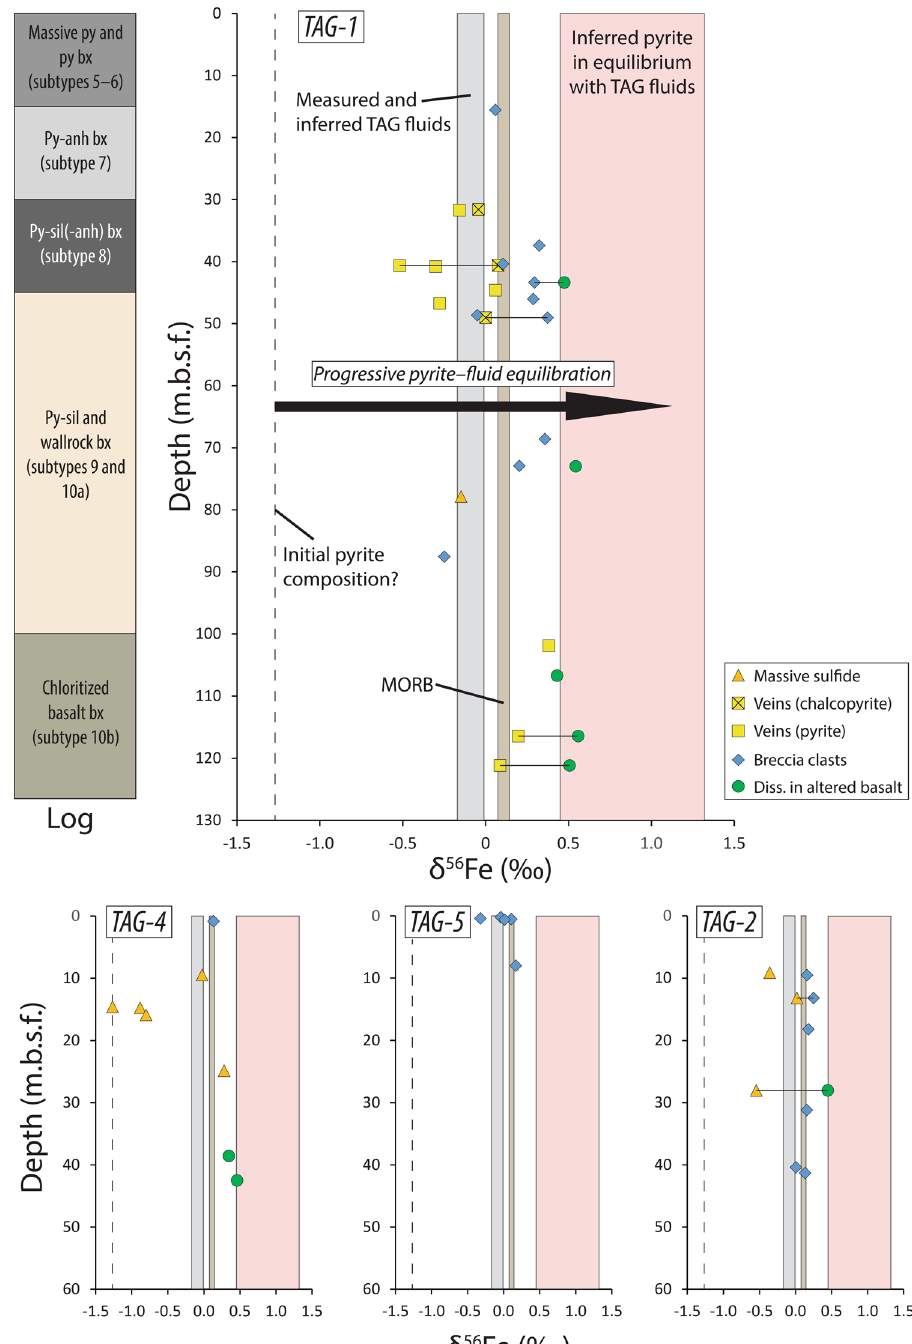
Fig. 3 Iron isotope results. The δ 56 Fe values of pyrite ( n = 47) and chalcopyrite ( n = 3) from TAG-1, TAG-2, TAG-4, and TAG-5, respectively, are plotted as a function of depth below the mound surface. Tie-lines connect sul fi de samples obtained from the same drill core piece. Included are the core log for TAG-1 44 and reference fi elds for MORB (brown) 23,56 and for measured 28 and inferred TAG hydrothermal fl uids (gray). The inferred range of δ 56 Fe values of pyrite in equilibrium with recent TAG hydrothermal fl uids (pink) was calculated using the fractionation factors of ref. 30 and ref. 34 . The lowest δ 56 Fe pyrite value of our dataset ( − 1.27 ‰ ; TAG-4) is used to illustrate a potential initial (disequilibrium) iron isotope composition of pyrite formed via inferred iron (poly)sul fi de precursors (dashed black line; cf. ref. 34 ). We interpret the observed range of δ 56 Fe values of different textural types of pyrite to re fl ect contrasting precipitation mechanisms (hydrothermal fl uid – seawater mixing vs. conductive cooling) and variable degrees of progressive hydrothermal maturation during the evolution of the TAG complex. See text for details. anh anhydrite, bx breccia, diss. disseminated, py pyrite, sil